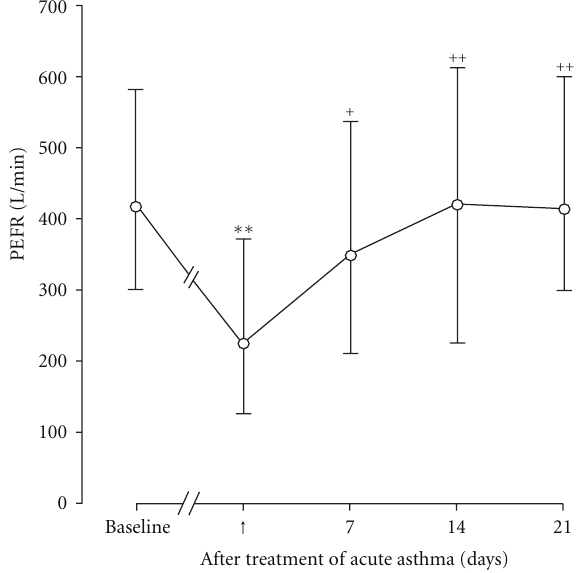
Figure 1: Time course changes in peak expiratory flow rate (PEFR) in asthmatic patients ( n = 30) before acute asthma exacerbations (baseline) and after treatment with oral glucocorticoids. ↑ : the start of treatment of acute asthma exacerbations with oral gluco- corticoids. Means and ranges are indicated by open circles with bars. Significant di ff erences from baseline are indicated by ∗∗ P < 0 . 01. Significant di ff erences from acute asthma exacerbations are indicated by + P < 0 . 05 and ++ P < 0 . 01. (Cited from [19]). CCL5 = CC Chemokine Ligand 5), and granulocyte- macrophage colony stimulating factor (GM-CSF), in pri- mary cultures of epithelial cells or cell lines (Table